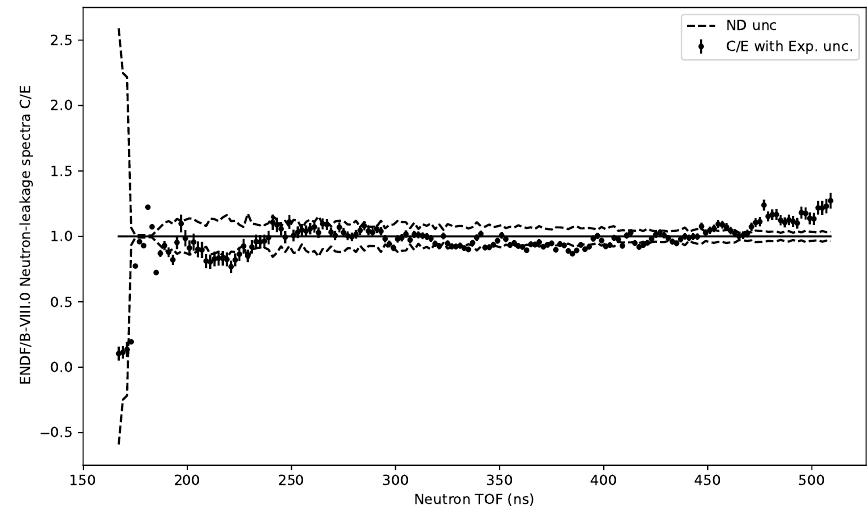
Figure 3. The same as Fig. 1 except for Pu LLNL pulsed-sphere neutron-leakage spectra measured with a sphere of 0.7 mean-free path, at 26 degree with an NE-213 detector.